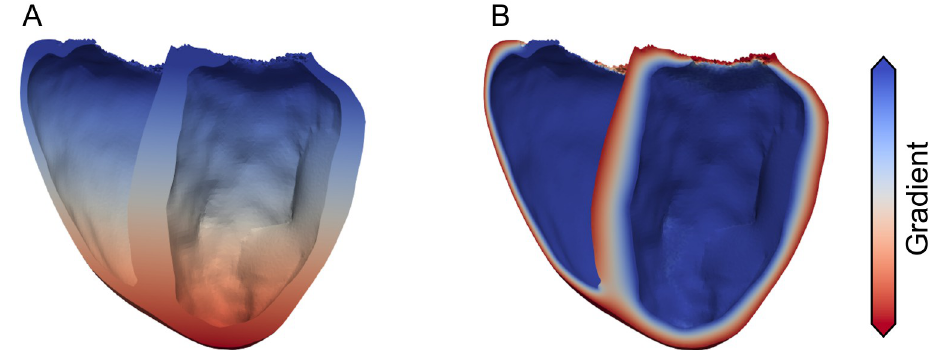
Fig 4. Transmural and apico-basal gradients. Transmural (A) and apico-basal (B) gradient used to define different gradients in APD. The gradients were flipped for respective APD lengthening; meaning that for example for a shortening in APD from base towards apex, blue represents 0 ms and red the APD shortening; for a shortening towards the base ( i.e . a lengthening towards apex), blue would represent the APD shortening and red 0 ms.